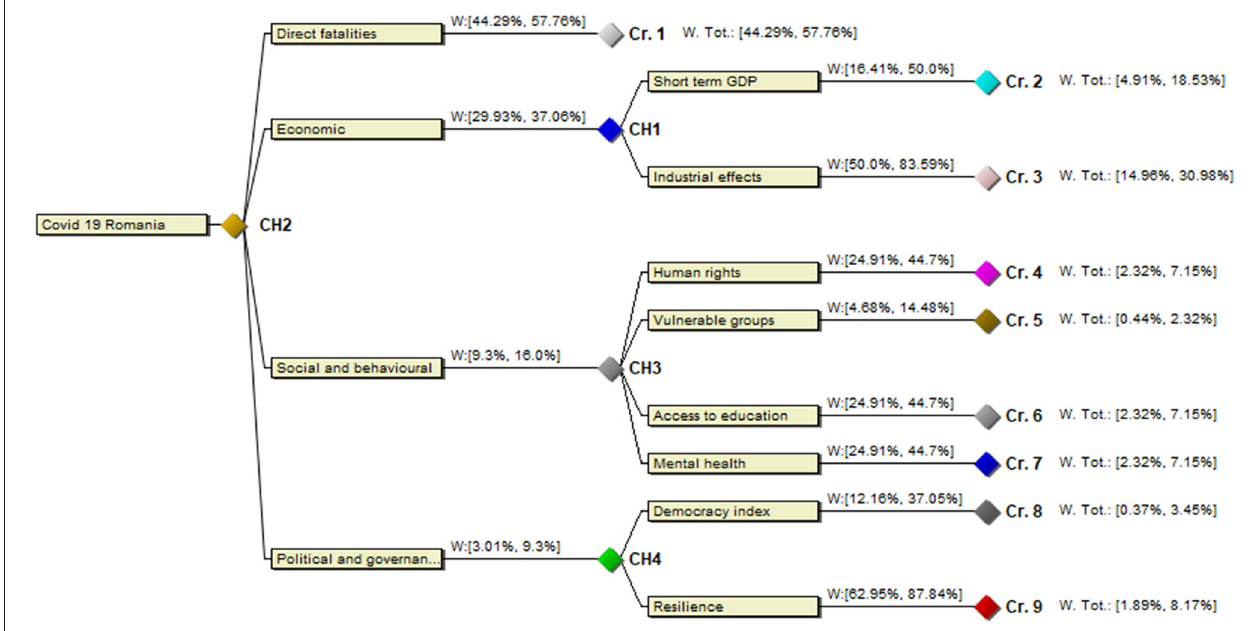
FIGURE 5 | Criteria tree for COVID-19 response measures in Romania.